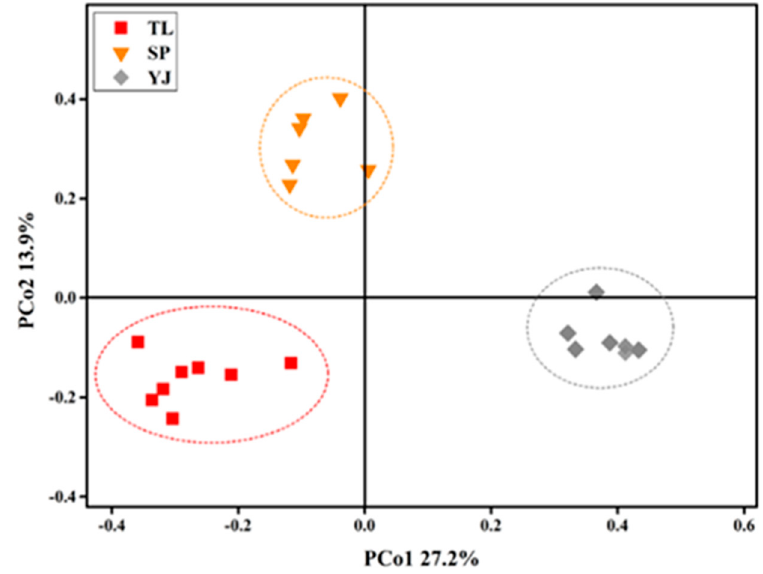
Figure 2. Result of principal coordinate analysis (PCoA) of fungal communities in soils from different sampling sites. TL, SP, and YJ indicate that the soil samples were collected from Tongliao, Siping, and Yanji, respectively.